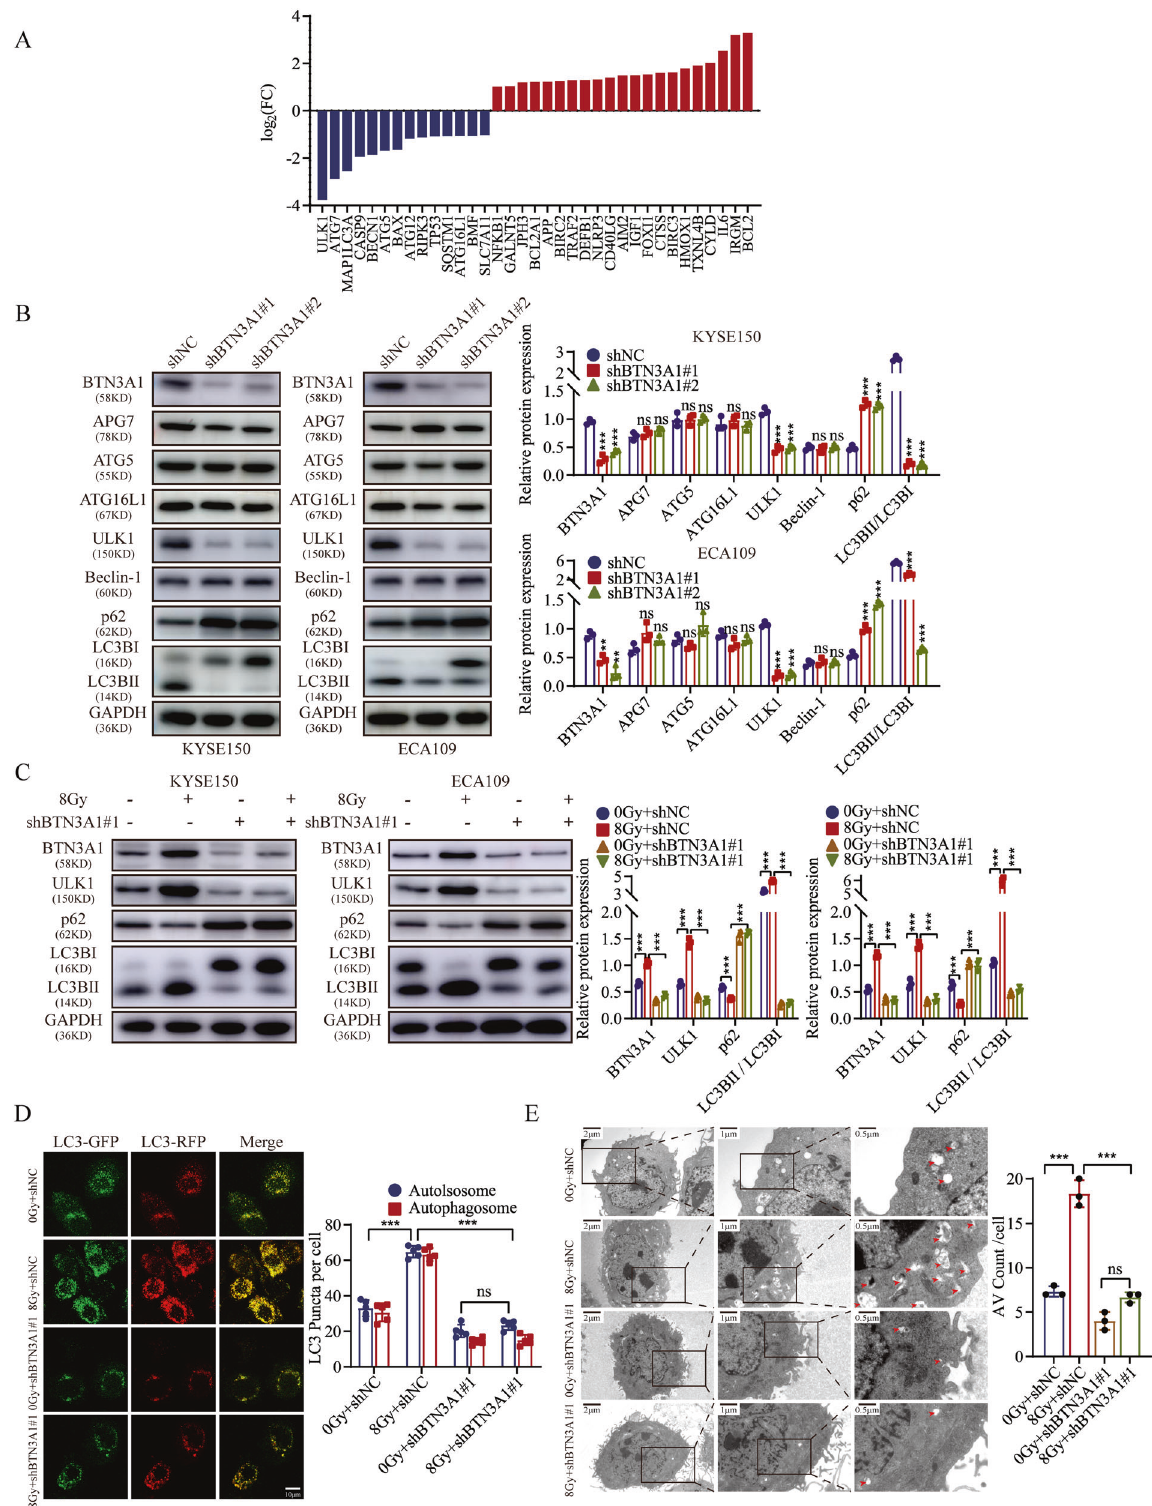
Fig. 4 BTN3A1 knockdown suppresses autophagy in ESCC cells. A 35 differentially expressed genes were identi fi ed in KYSE150 cells transfected with shBTN3A1 or shNC by death-related qPCR array. B Immunoblots of the key autophagy-related proteins in cells with BTN3A1 knockdown. C Control and BTN3A1-knockdown cells were treated with IR (8 Gy) and cultured for 24 h, followed by immunoblotting with the indicated antibodies. These data are representative of three independent experiments. *** p < 0.001 compared to the control group. D Control and BTN3A1-KD KYSE150 cells were co-transfected with mRFP-GFP-LC3B then treated with or without radiation (8 Gy). The confocal microscopy analysis is shown. Scale bar: 10 µm. E Autophagosomes were observed by transmission electron microscopy. Red arrows indicated autophagosomes formation. Scale bar: 2 µm. The data are presented as the means ± SD from three independent experiments. ns, no signi fi cance, * p < 0.05, ** p < 0.01 and *** p < 0.001. Cell Death and Disease (2022)